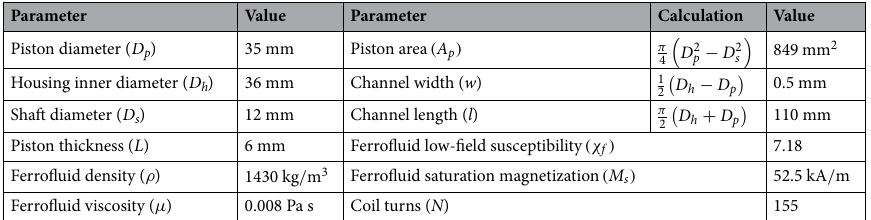
Table 1. Experimental actuator dimensions and properties.